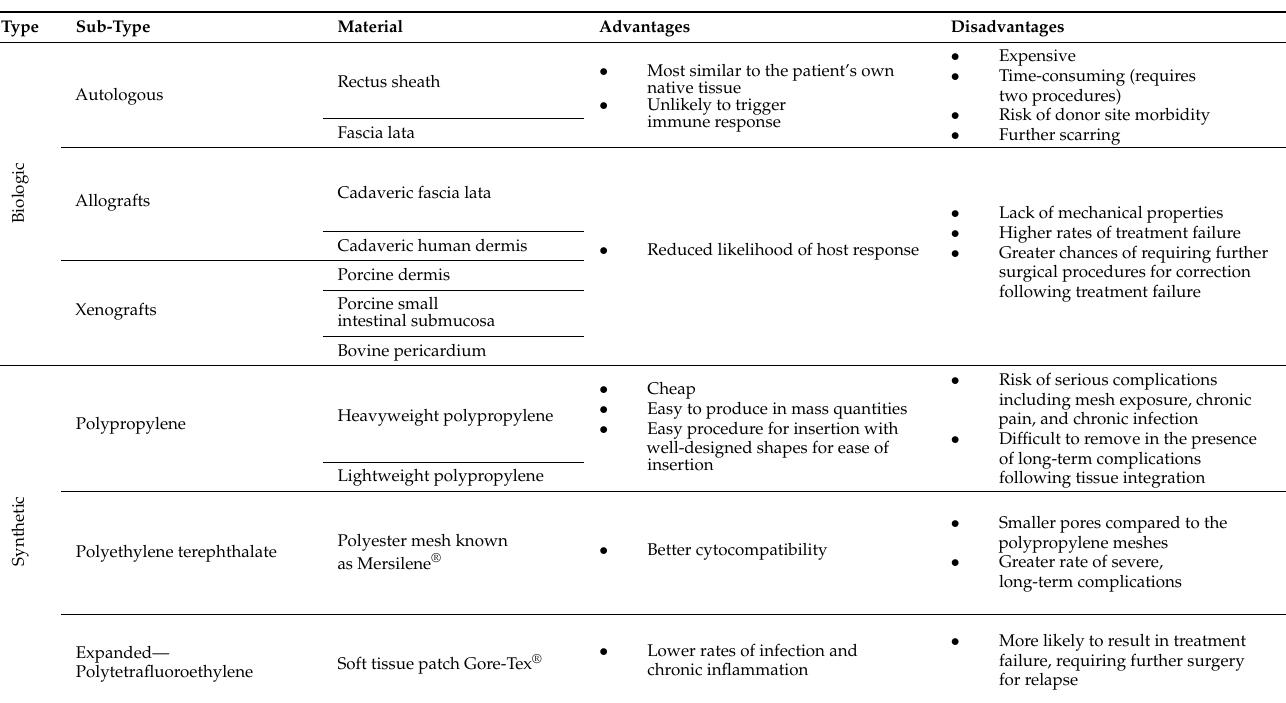
Table 1. Materials that have been used clinically to augment pelvic organ prolapse (POP) surgical repair. Disadvantage of the biological materials is their lack of mechanical properties, especially long-term post